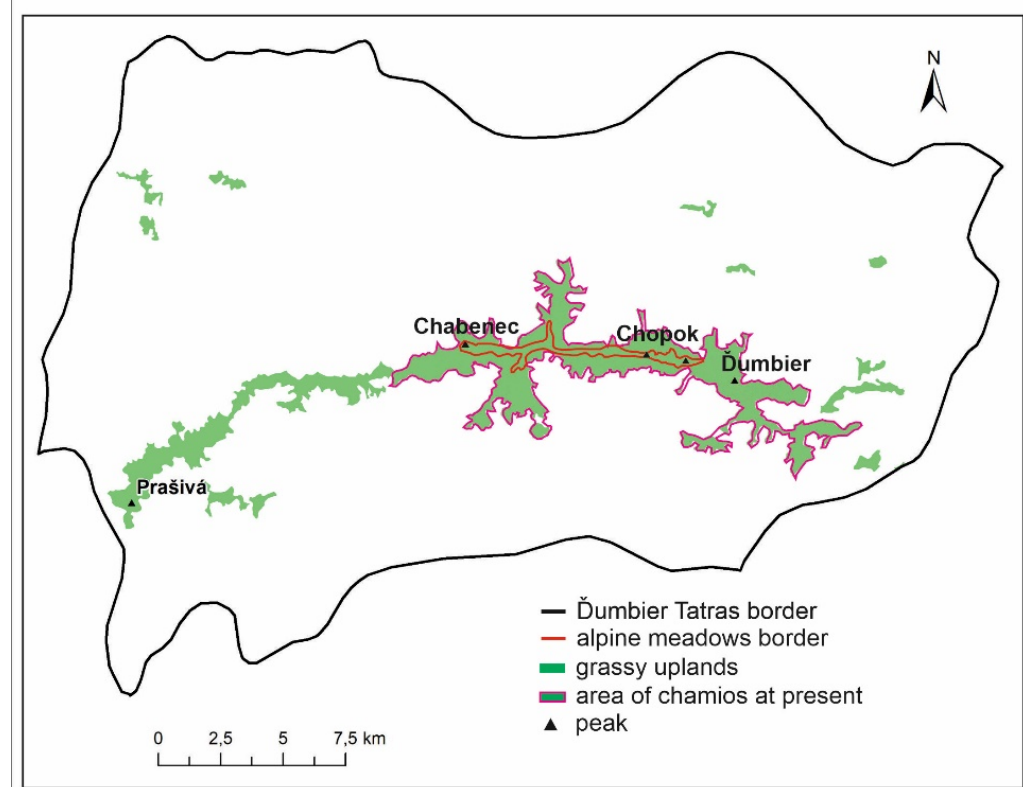
Figure 17. Comparison of the original alpine meadows and anthropogenically formed uplands with the current area of distribution of the Alpine chamois (Source: authors’ research, National Atlas of Slovak Republic, 2002).